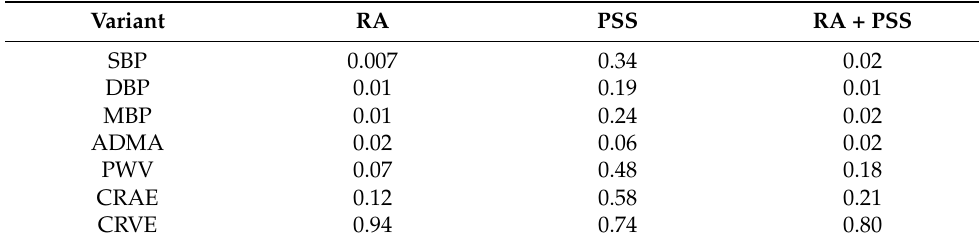
Table 2. Statistical differences between diseases group and control group ( p -value). Legend: RA: rheumatoid arthritis; PSS: primary Sjögren